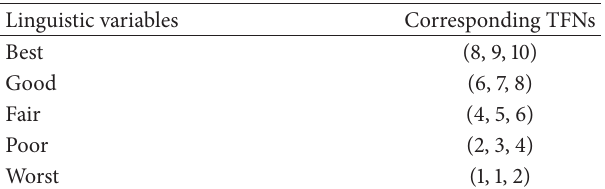
Table 2: Linguistic variables for the performance ratings of alterna-